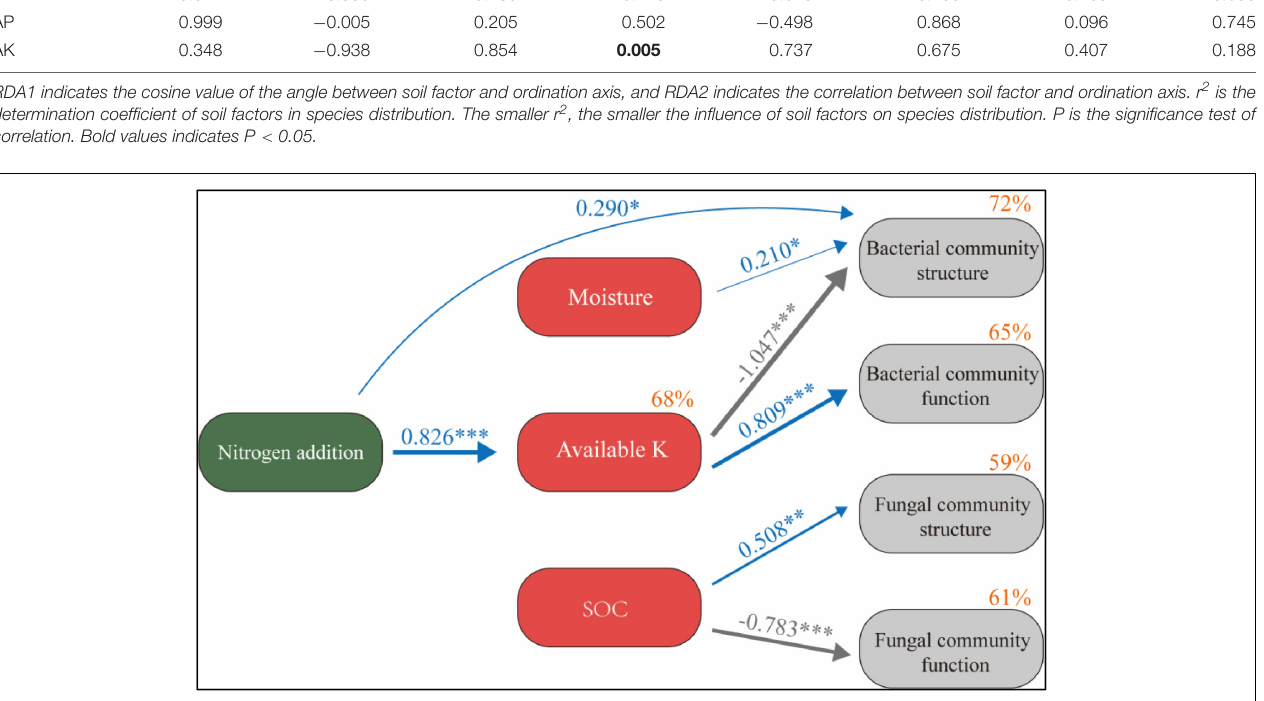
FIGURE 8 | Structural equation model of N application on the soil microbial system reveals the relationship between SOC, moisture, available K, and microbial community structure and function. Width of the arrow head indicates the strength of the relationship. Blue arrows indicate a significant positive relationship, and gray arrows indicate a significant negative relationship ( P < 0.05). Non-significant paths have been deleted. Percentages close to variables refer to the variance accounted for by the model (R 2 ). * P < 0.05, ** P < 0.01, *** P <